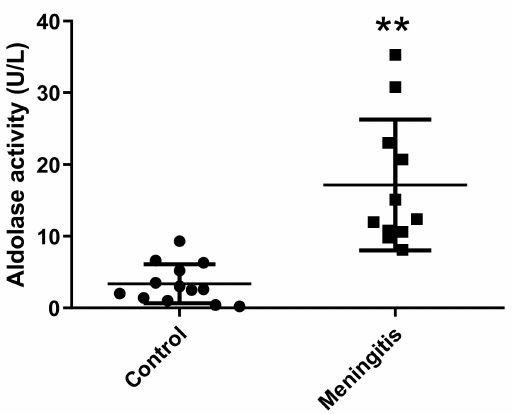
Figure 6. Salivary aldolase activity (U/L) in pigs with meningitis compared with healthy controls. Lines indicate the minimum, median, and maximum values. Asterisks indicate statistically significant differences (** p = 0.001). Circles and squares represent the sample values of control and meningitis groups,